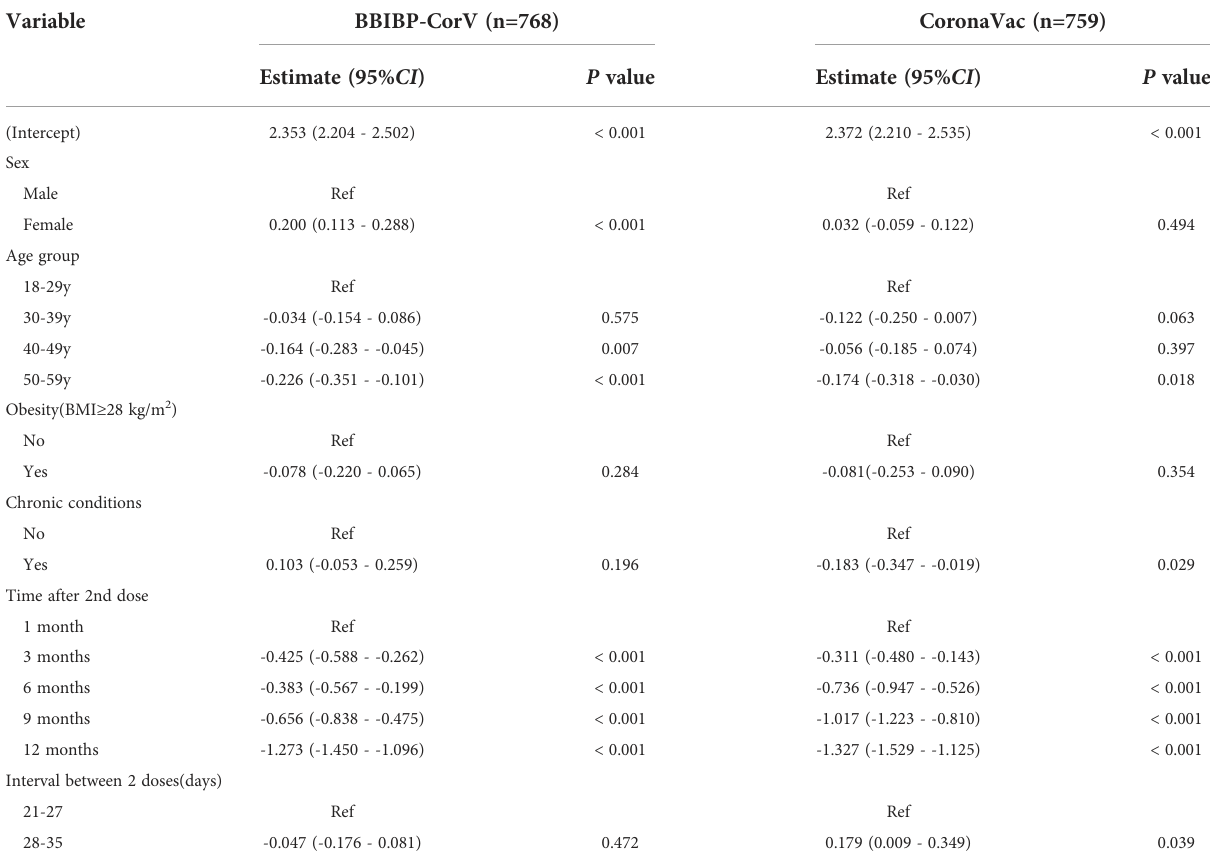
TABLE 4 Multiple linear regression analyses of GMCs of